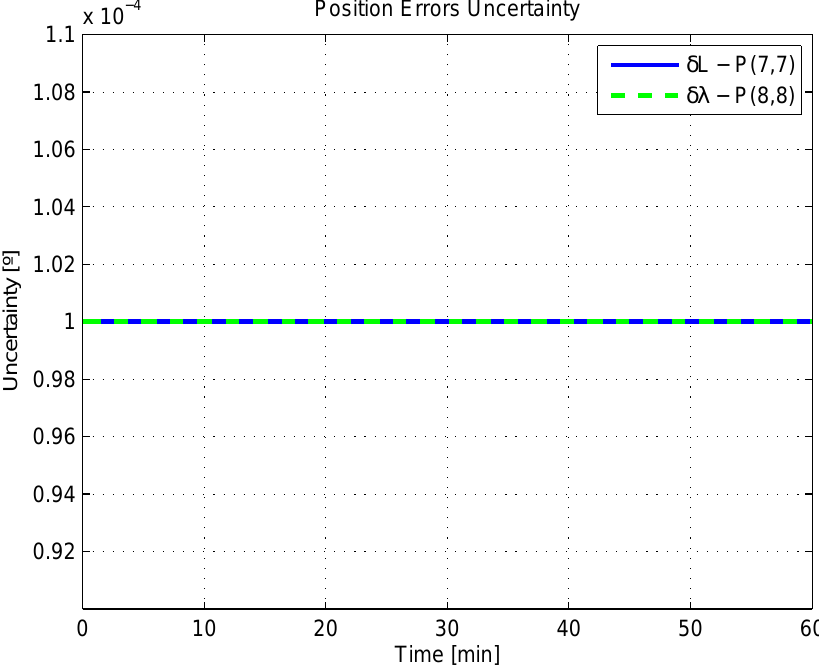
Figure 3. Position errors uncertainty in the simulated test.